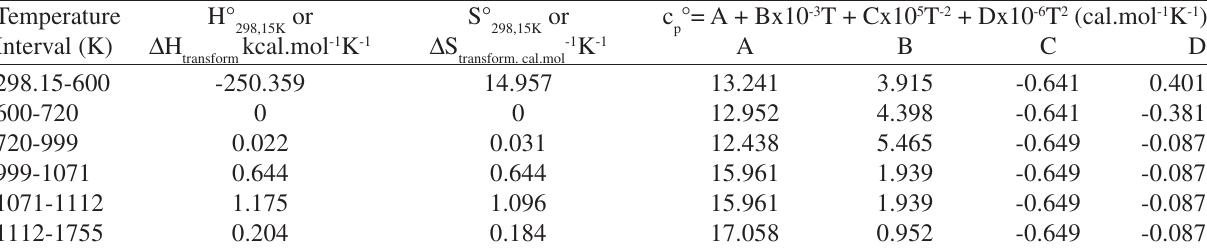
Table 2 . Thermodynamic data of the species Ce function of temperature, enthalpies and entropies at 298.15K , as well as enthalpies and entropies of phase transformation.